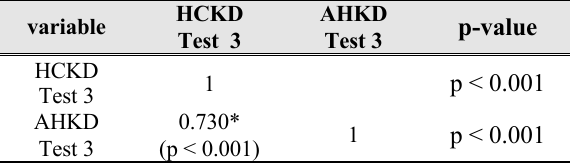
Correlation between HCKD and AHKD (Test 3)